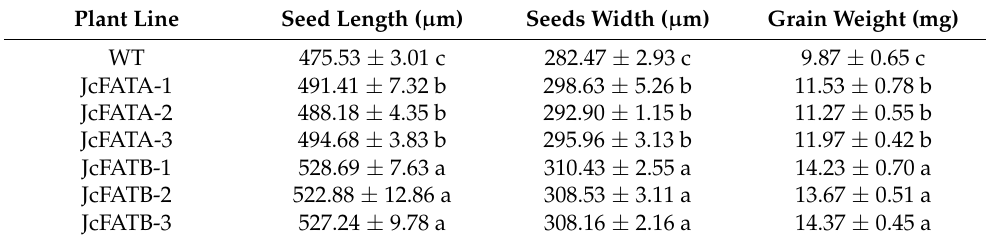
Table 1. Mature seed size and weight of the JcFATA and JcFATB ectopic expression lines of A. thaliana . Plant Line Seed Length ( µ m) Seeds Width ( µ m) Grain Weight (mg) WT 475.53 ± 3.01 c 282.47 ± 2.93 c 9.87 ± 0.65 c JcFATA-1 491.41 ± 7.32 b 298.63 ± 5.26 b 11.53 ± 0.78 b JcFATA-2 488.18 ± 4.35 b 292.90 ± 1.15 b 11.27 ± 0.55 b JcFATA-3 494.68 ± 3.83 b 295.96 ± 3.13 b 11.97 ± 0.42 b JcFATB-1 528.69 ± 7.63 a 310.43 ± 2.55 a 14.23 ± 0.70 a JcFATB-2 522.88 ± 12.86 a 308.53 ± 3.11 a 13.67 ± 0.51 a JcFATB-3 527.24 ± 9.78 a 308.16 ± 2.16 a 14.37 ± 0.45